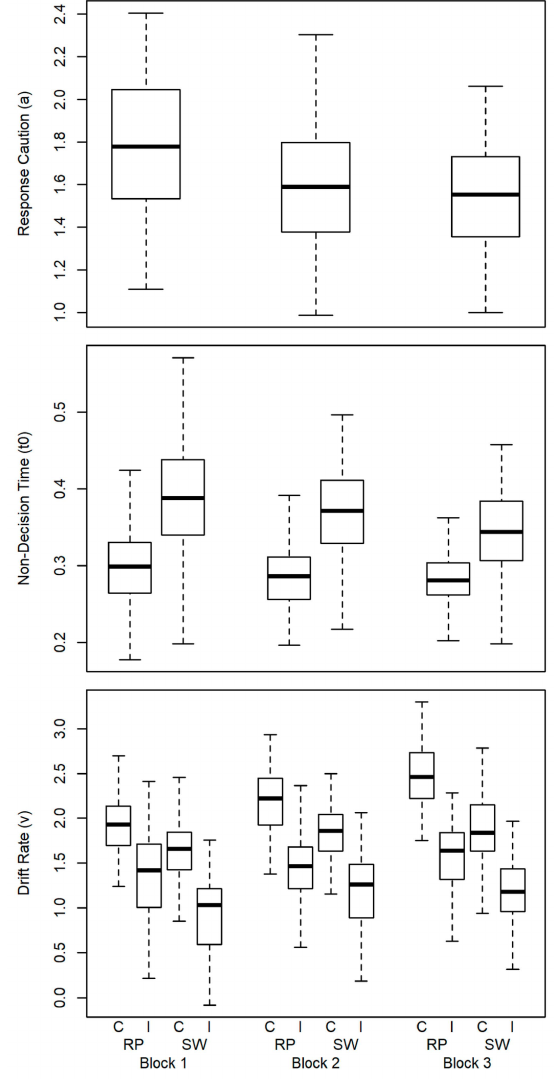
Figure 3. Boxplots of diffusion model (DM) parameters. Upper panel: response caution split by block; middle panel: non-decision time, split by block and task repeat (RP)/switch (SW) trials; lower panel: drift rates, split by block, task repeat (RP)/switch (SW) and response congruent (C)/incongruent (I)